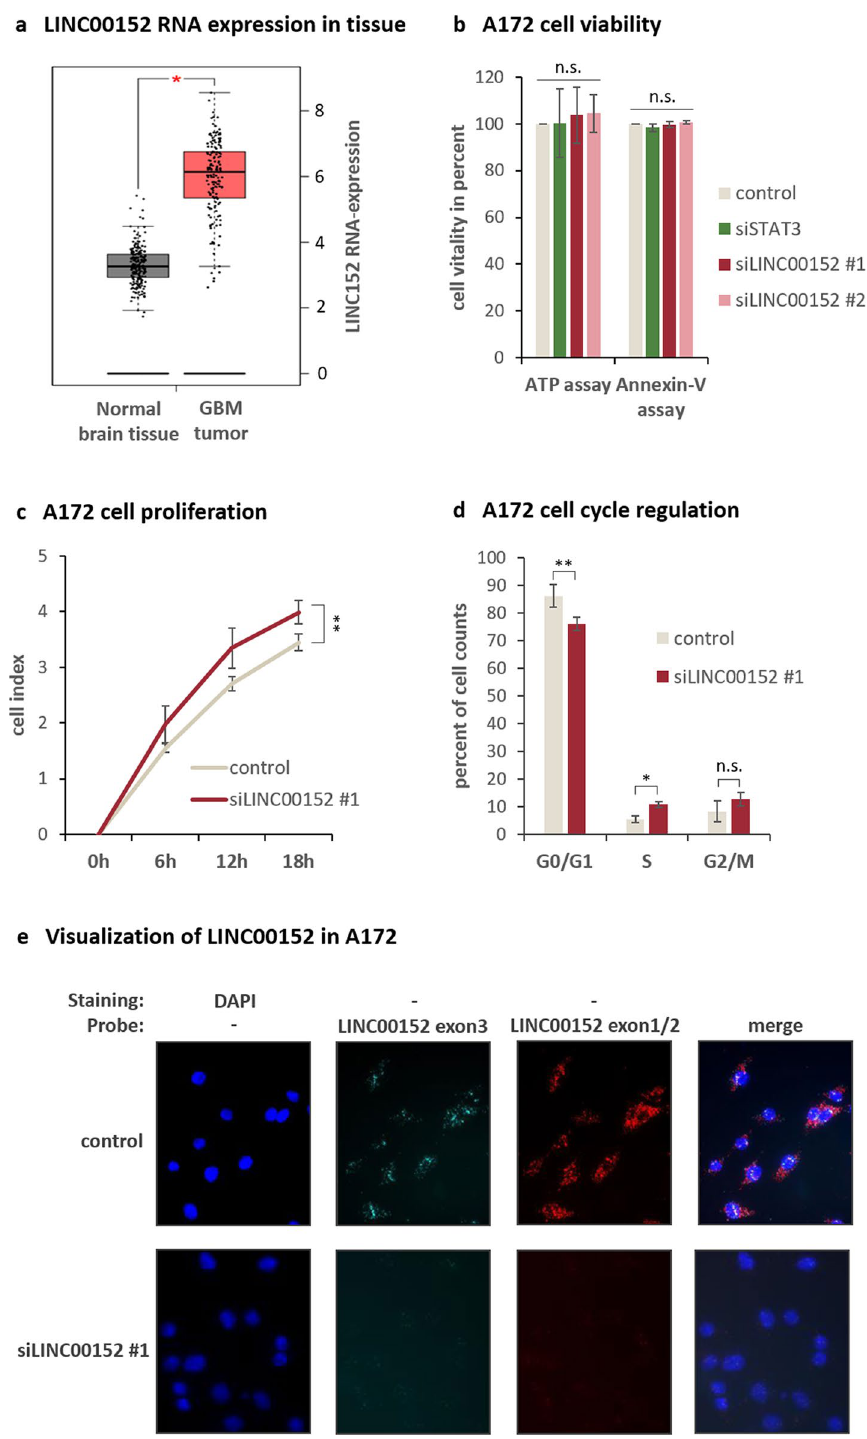
Figure 1. Characterization of LINC00152 functions in A172 glioblastoma cells. ( a ) GEPIA Plot displayed an increased LINC00152 expression in Glioblastoma Multiforme (GBM) tumor samples compared to healthy donor samples (normal brain tissue). ( b ) Cell viability was determined 48 h after LINC00152 and STAT3 knockdown using an ATP-based and an Annexin-V assay. Values were normalized to a siRNA negative control. ( c ) LINC00152 was knocked down and cell proliferation was monitored over time in an incubator equipped with a microscope and camera (XCelligence ® ). The impedance is recorded by RTCA software (https:// www. agile nt. com/ en/ produ ct/ cell- analy sis/ real- time- cell- analy sis/ rtca- softw are) and given as cell index, which is a measure of cell proliferation. ( d ) DNA of A172 cells was labled with propidium iodide 72 h after siLINC00152 #1 and control siRNA transfection and the DNA content was measured by flow cytometry. ( e ) Specific probes targeting LINC00152 either in exon3 (detecting primary and spliced transcript) or intron-spanning in exon 1 and -2 (detecting just spliced transcripts) were added to formaldehyde fixed A172 cells 48 h after knockdown with siLINC00152 #1 and a negative control siRNA. Nuclei were counterstained with DAPI and images were